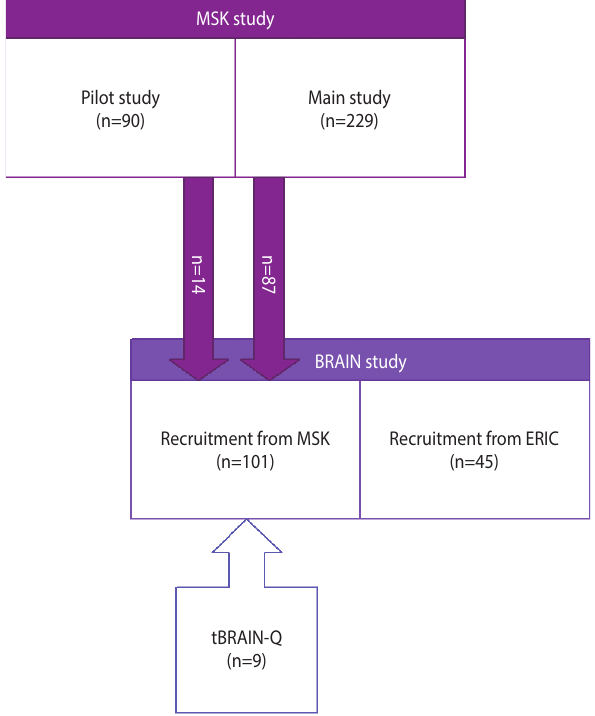
90 participant assessed within the pilot MSK and 87 of the 229 as- sessed within the main Oxford and Cambridge University players and English international rugby players (MSK study) who were also recruited in the BRain health and healthy AgeINg in retired rugby union players (BRAIN) study formed the sample of the present